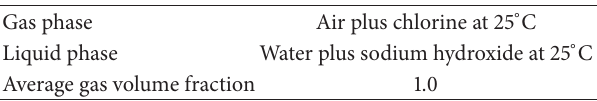
Table 3: Operating conditions.